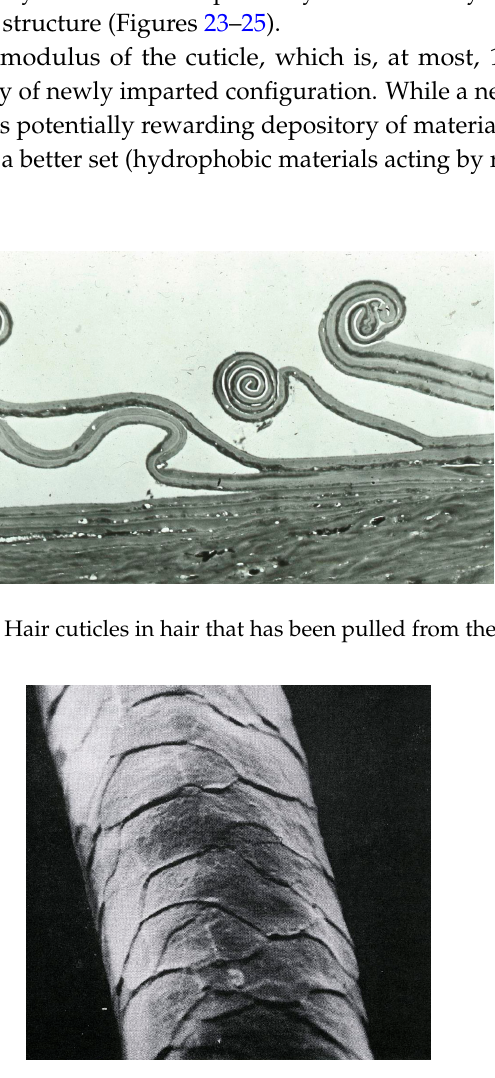
Figure 24. Scanning electron micrograph of intact mohair.